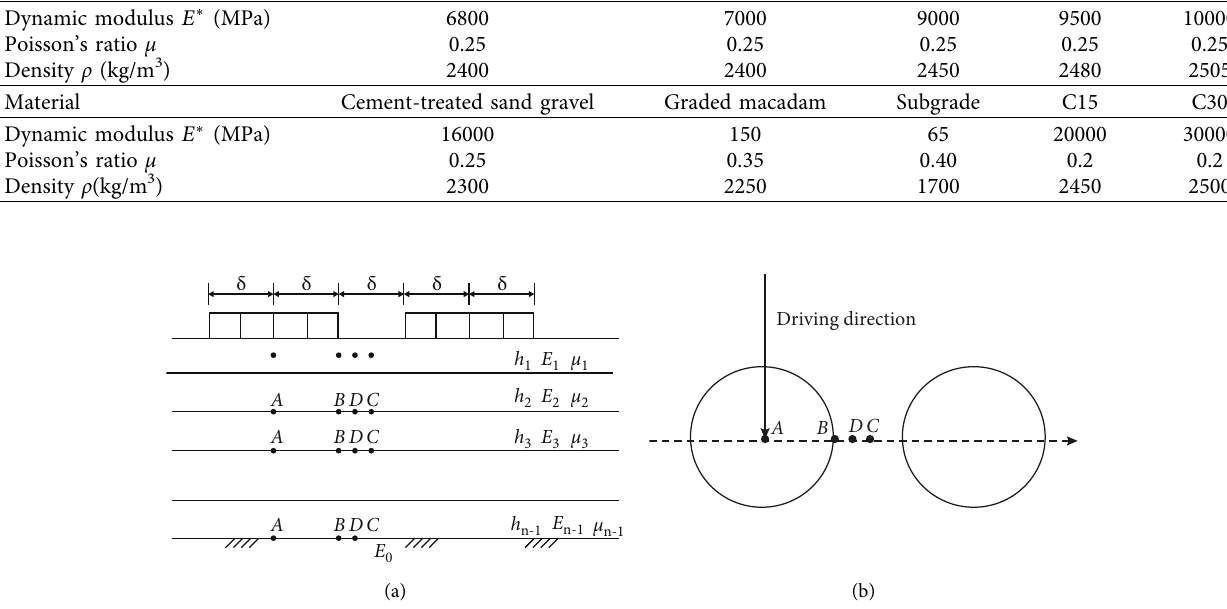
Figure 12: Mechanical response calculation points in the elastic multilayer theory assumption.